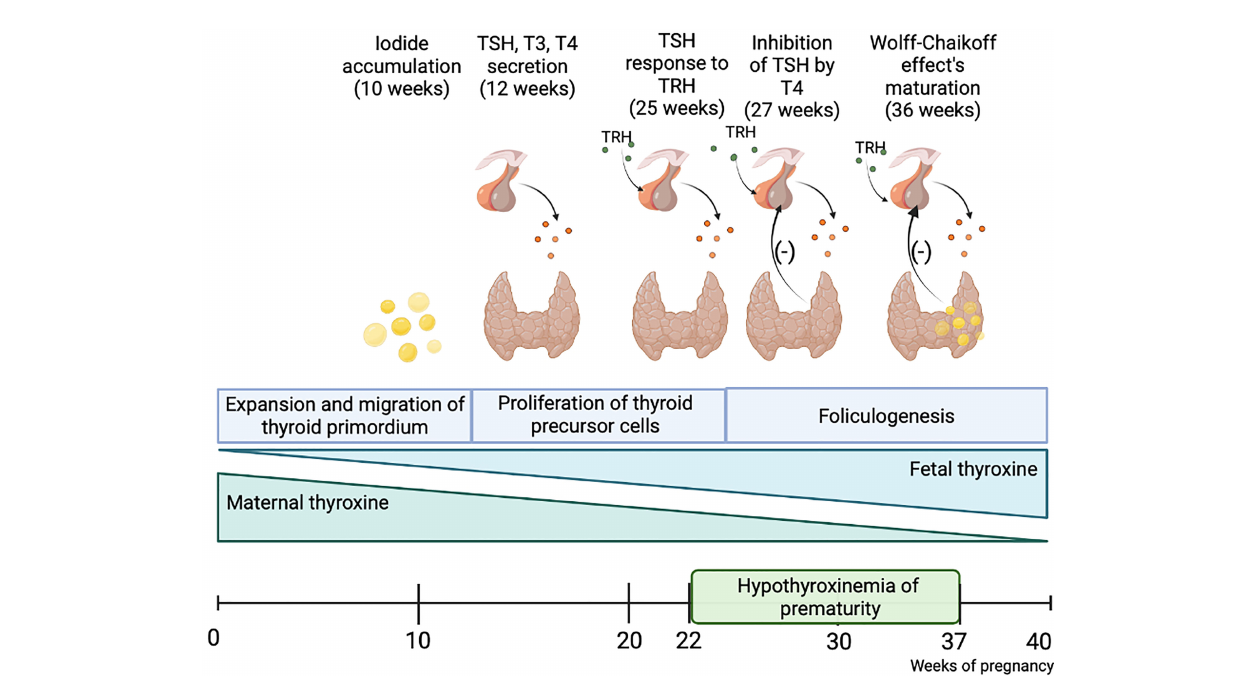
FIGURE 1 | Fetal thyroid gland maturation. The fetus is dependent on maternal thyroid hormones supplementation until the end of the fi rst trimester. The hypothalamus-pituitary-thyroid axis is not suf fi ciently developed until the end of pregnancy, thus preterm-born children present a disorder called hypothyroxinemia of prematurity, which results in numerous consequences. Created with